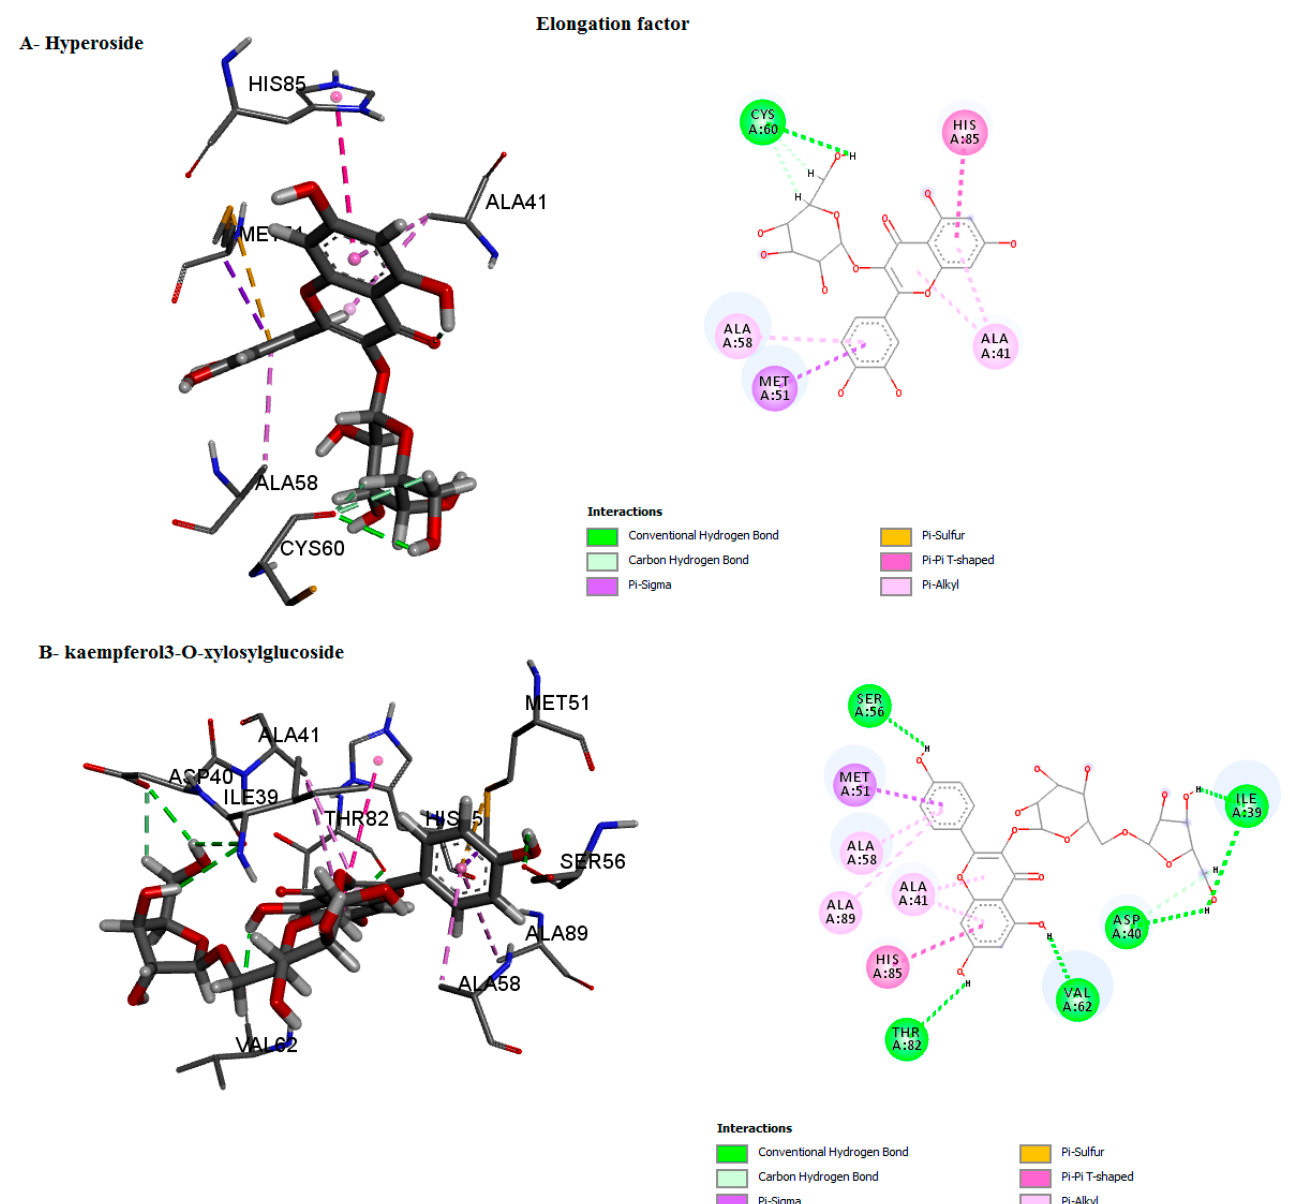
Figure 8. Predicted binding mode for elongation factor with kaempferol3-O-xylosylglucoside and hyperoside D.